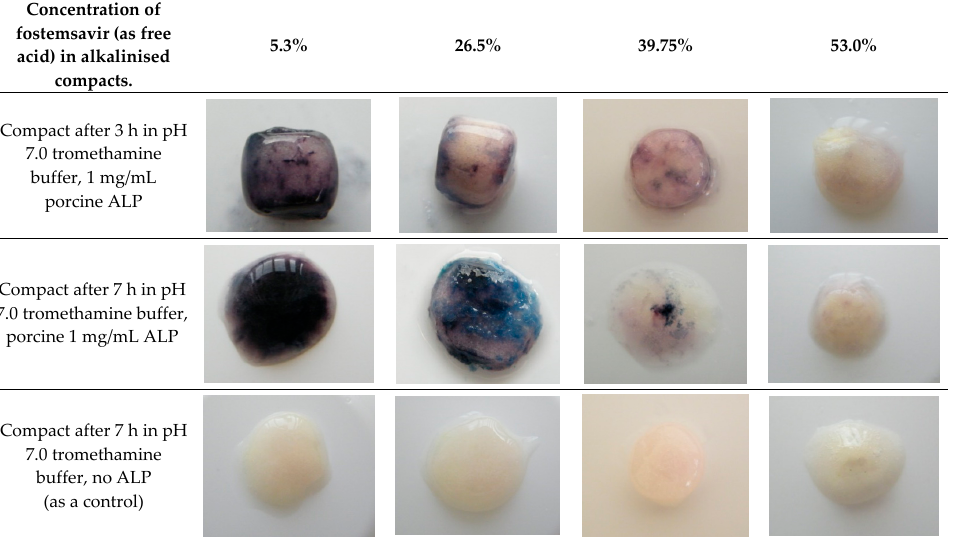
Figure 7. Hydrated compacts containing various concentrations of fostemsavir, pH-adjusted with 372 tromethamine.